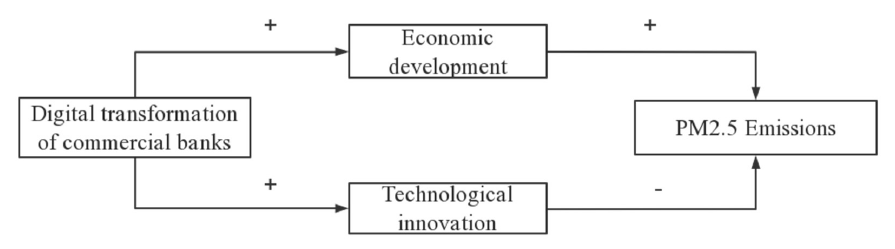
Figure 1. The mechanism by which DTCB affects air pollution.